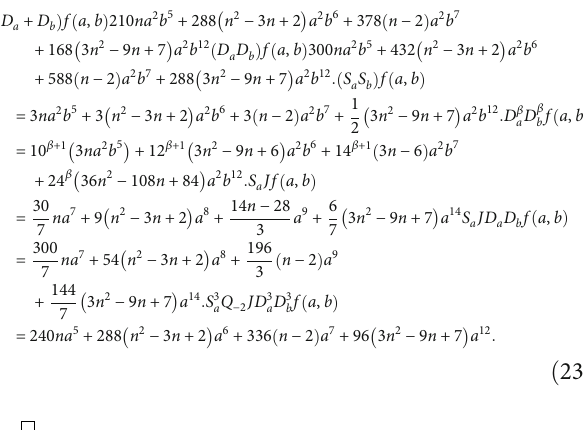
Figure 12: Comparison of Γ graphs of